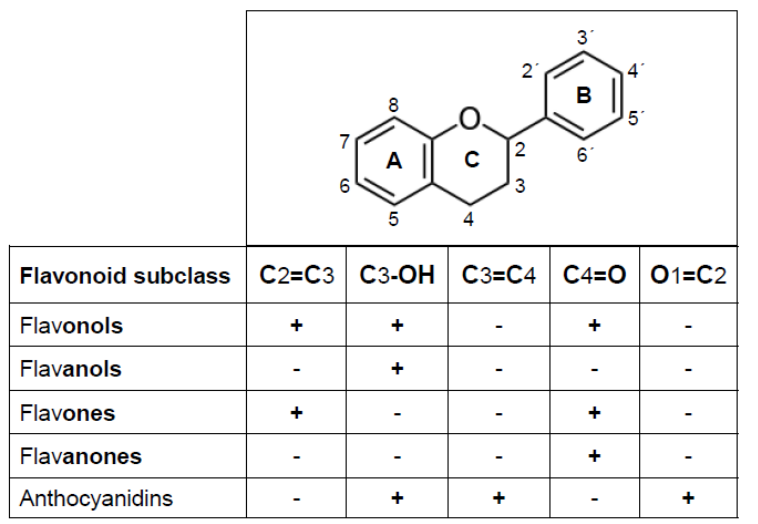
Figure 1. Flavan nucleus, 2-phenyl-3,4-dihydro-2H-1-benzopyran skeleton, common to all flavo- noids (C6–C3–C6).